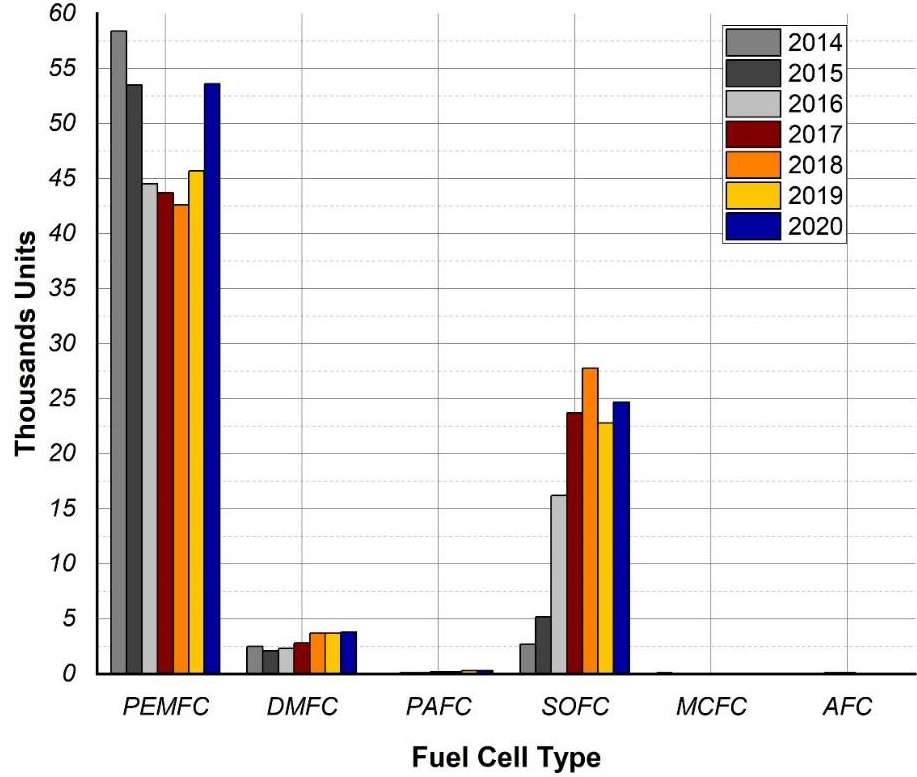
Figure 3. Fuel cell shipments.